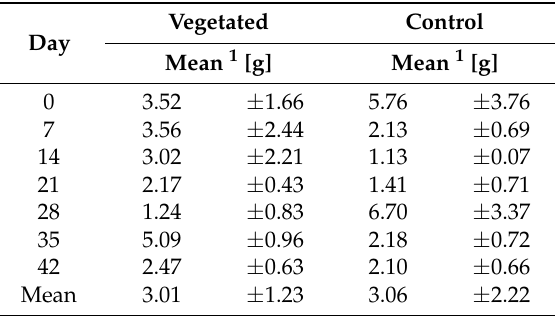
Table A2. Mean C. praegracilis new growth.